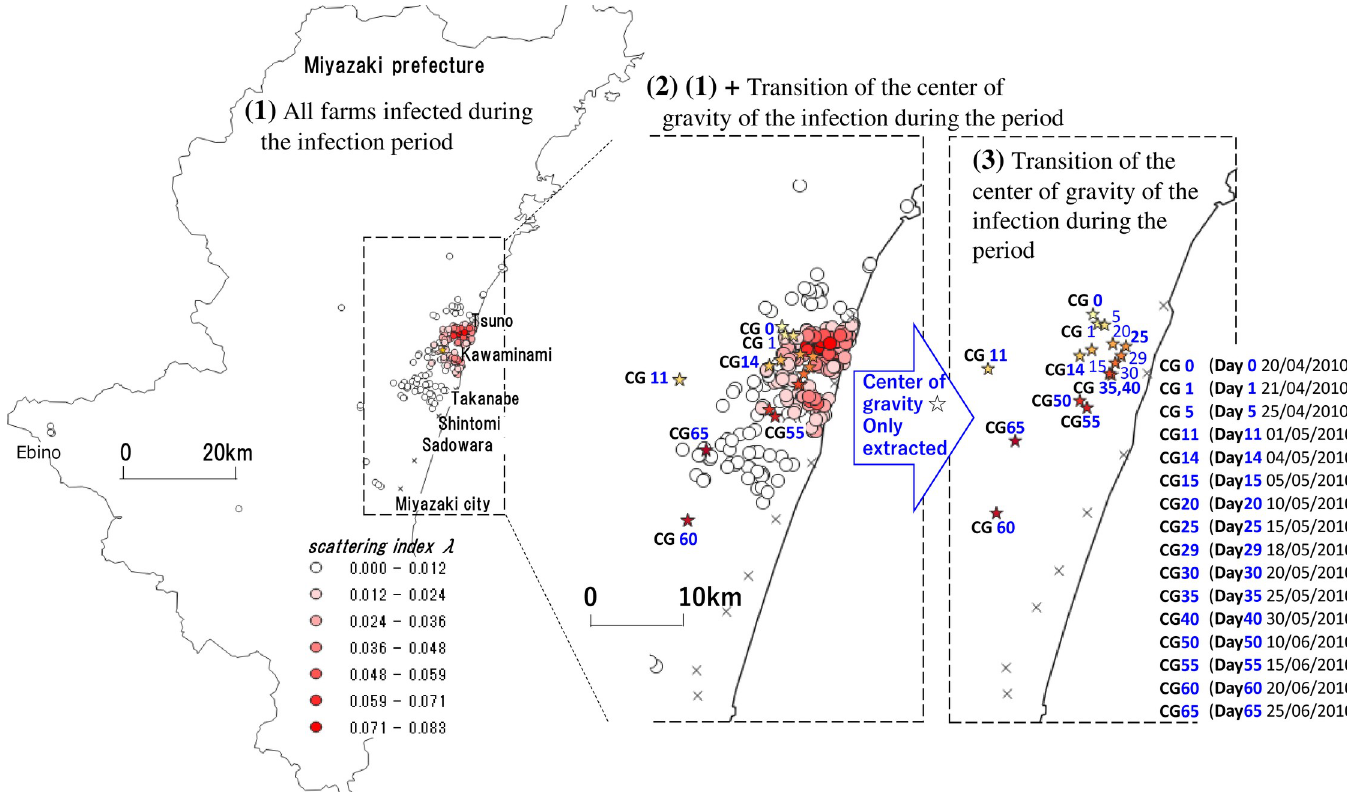
Fig 6. Location of all infected farms and the transition of the center of gravity during the infection period. In Fig 6- (1), the circles show the area of all farms infected during the infection period (Day 0 (20/04/2010) to Day 65 (25/06/2010)). The tonal gradation shows the scattering index of “the date of confirmed infection” of each farm. Fig 6-(2) plots some centers of gravity (CG0, CG1, CD5, ... , CG65) that shift during the infection period in Fig 6-(1). Fig 6-(3) shows only the center of gravity (CG0, CG1, CD5, ... , CG65) of Fig 6-(2).